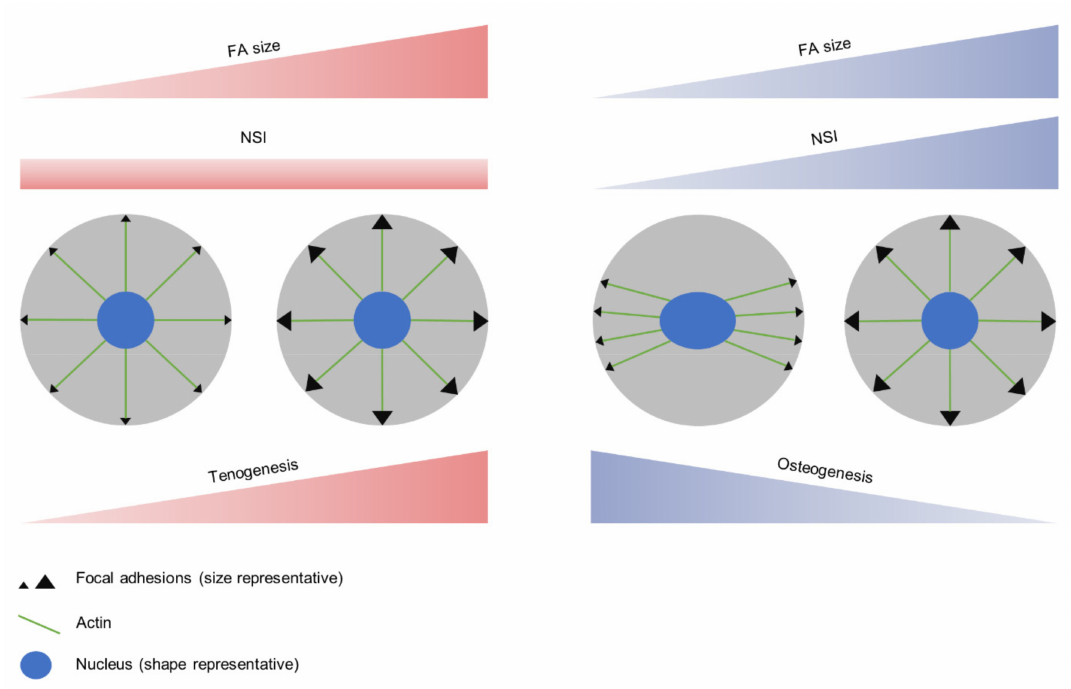
Figure 4. Di ff erentiation of hAMSCs is regulated by the tension applied, which depends on FA size (tension module) and distribution (tension orientation). Cell response varies according to the fate of di ff erentiation, with FA distribution remaining homogeneously around the cell perimeter in tenogenesis but polarizing for smaller FA sizes in osteogenesis. Both di ff erentiation processes are enhanced at higher levels of tension applied on the nucleus as a combination of the two factors.